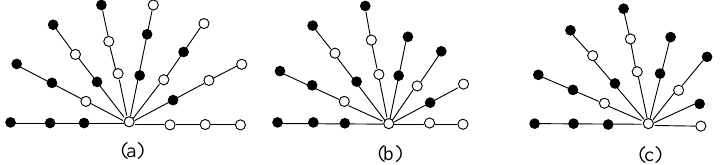
Figure 4: Three starlike trees whose largest branch at its central vertex has size 3 .